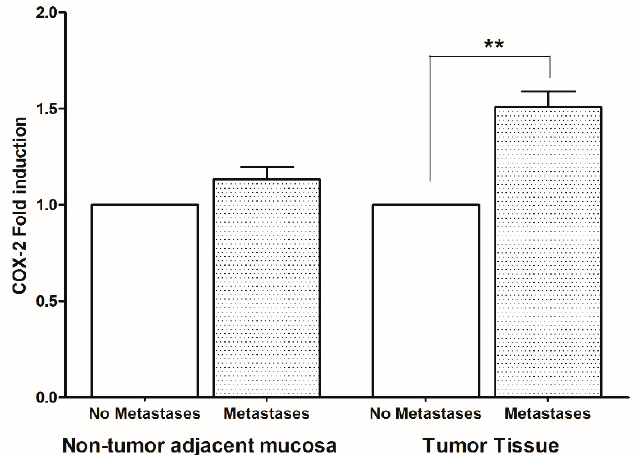
Figure 2. Cyclooxygenase-2 (COX-2) gene expression levels (mean ± SD) in non-tumor adjacent mucosa and tumor tissue from colorectal cancer patients with and without metastases. Data are expressed as Fold induction. ** p < 0.02 (Student’s t -test).